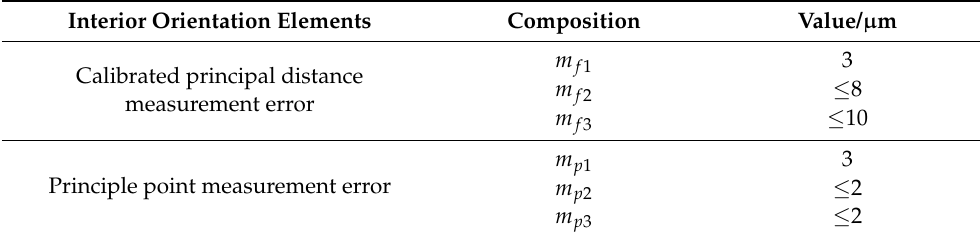
Table 4. Indicators decomposed into interior orientation elements